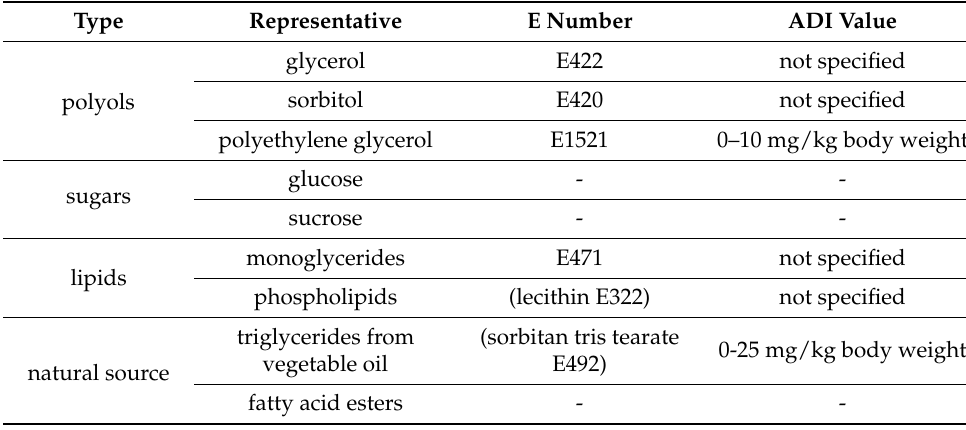
Table 1. Commonly used plasticizers in food application